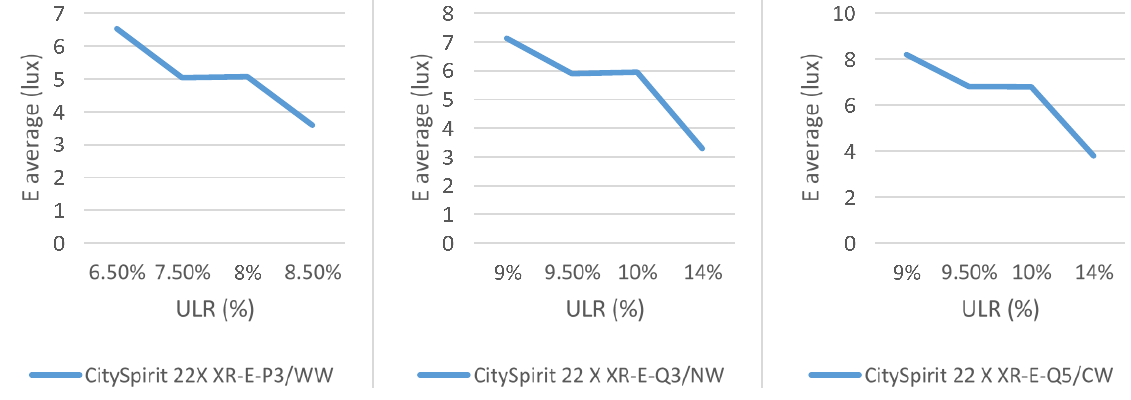
Figure 1. Illuminance regarding the ULR.